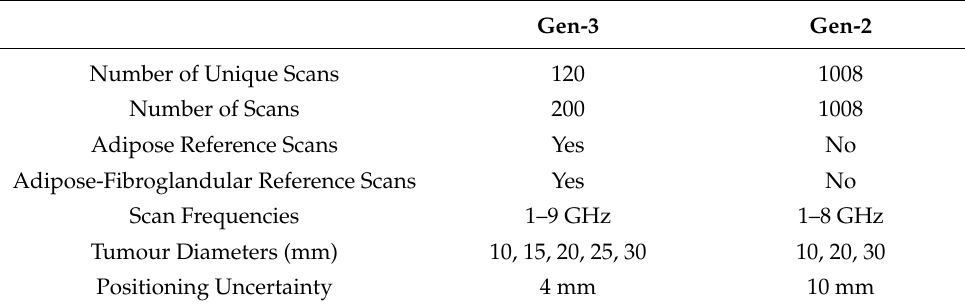
Table 1. UM-BMID Gen-3 and Gen-2